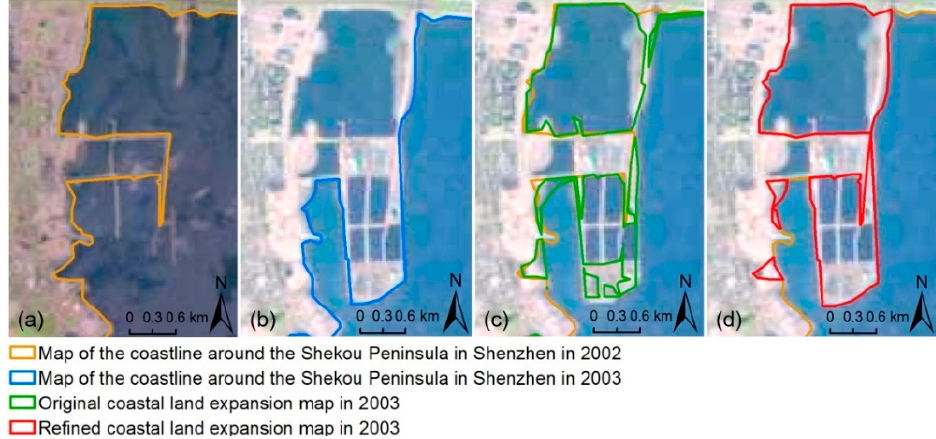
Figure 4. An example of extracting coastal reclamation of one year. ( a ) Map of the coastline around the Shekou Peninsula in Shenzhen in 2002; ( b ) map of the coastline around the Shekou Peninsula in Shenzhen in 2003; ( c ) original coastal land expansion map in 2003; and ( d ) refined coastal land expansion map in 2003. For each subfigure, the basemap is the true color composition of Landsat imagery in the corresponding year.